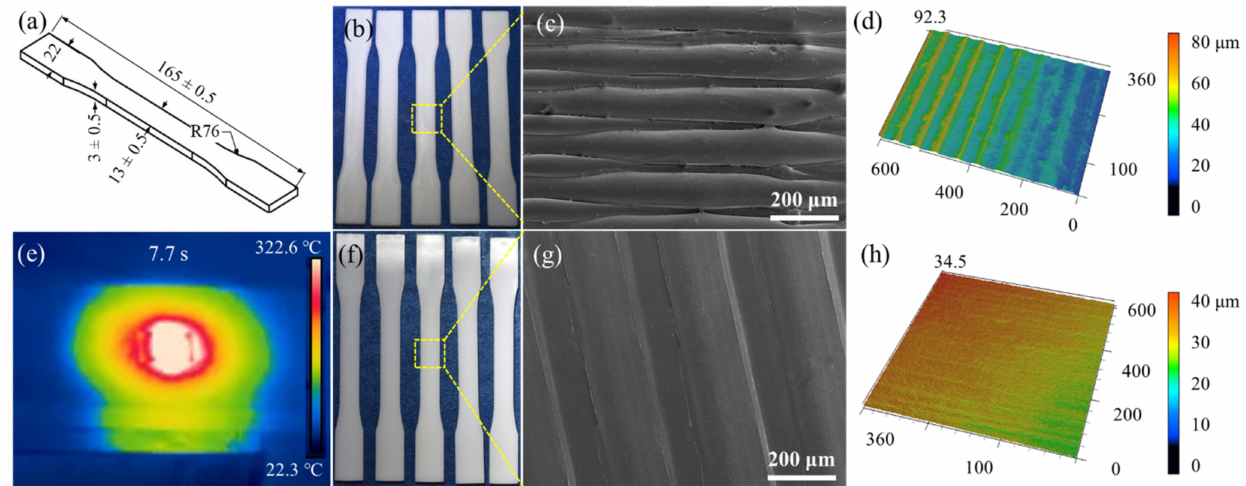
Figure 4. The surface morphology of tensile specimens before and after laser polishing: ( a ) specimen size; ( b , c ) macroscopic and microscopic surface morphologies of as-received specimen; ( d ) 3D topographic image of as-received specimen; ( e ) real-time monitoring of temperature field; ( f , g ) macroscopic and microscopic surface morphologies of laser-polished specimen; ( h ) 3D topographic image of laser-polished